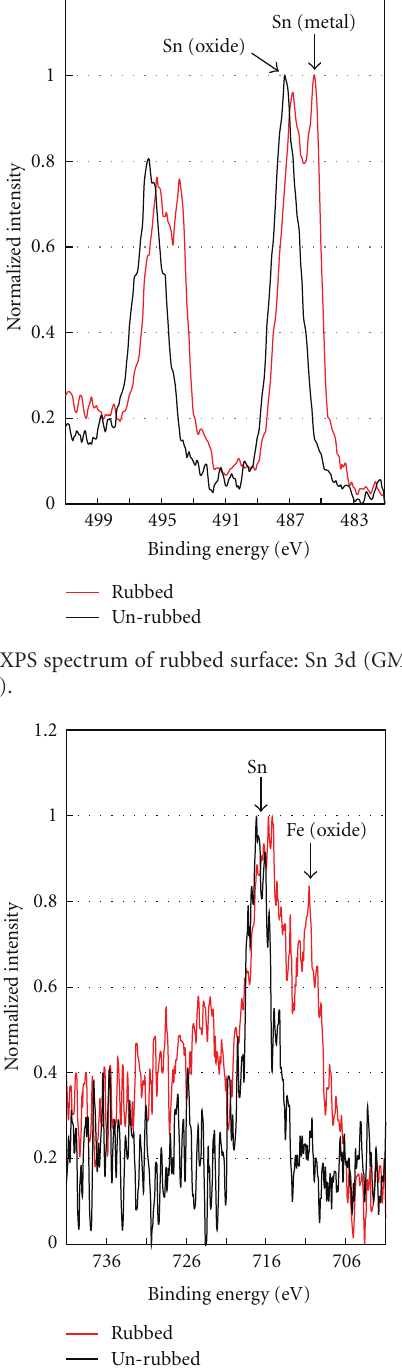
Figure 13: XPS spectrum of rubbed surface: Fe 2p (GMO in PAO for 120 min).